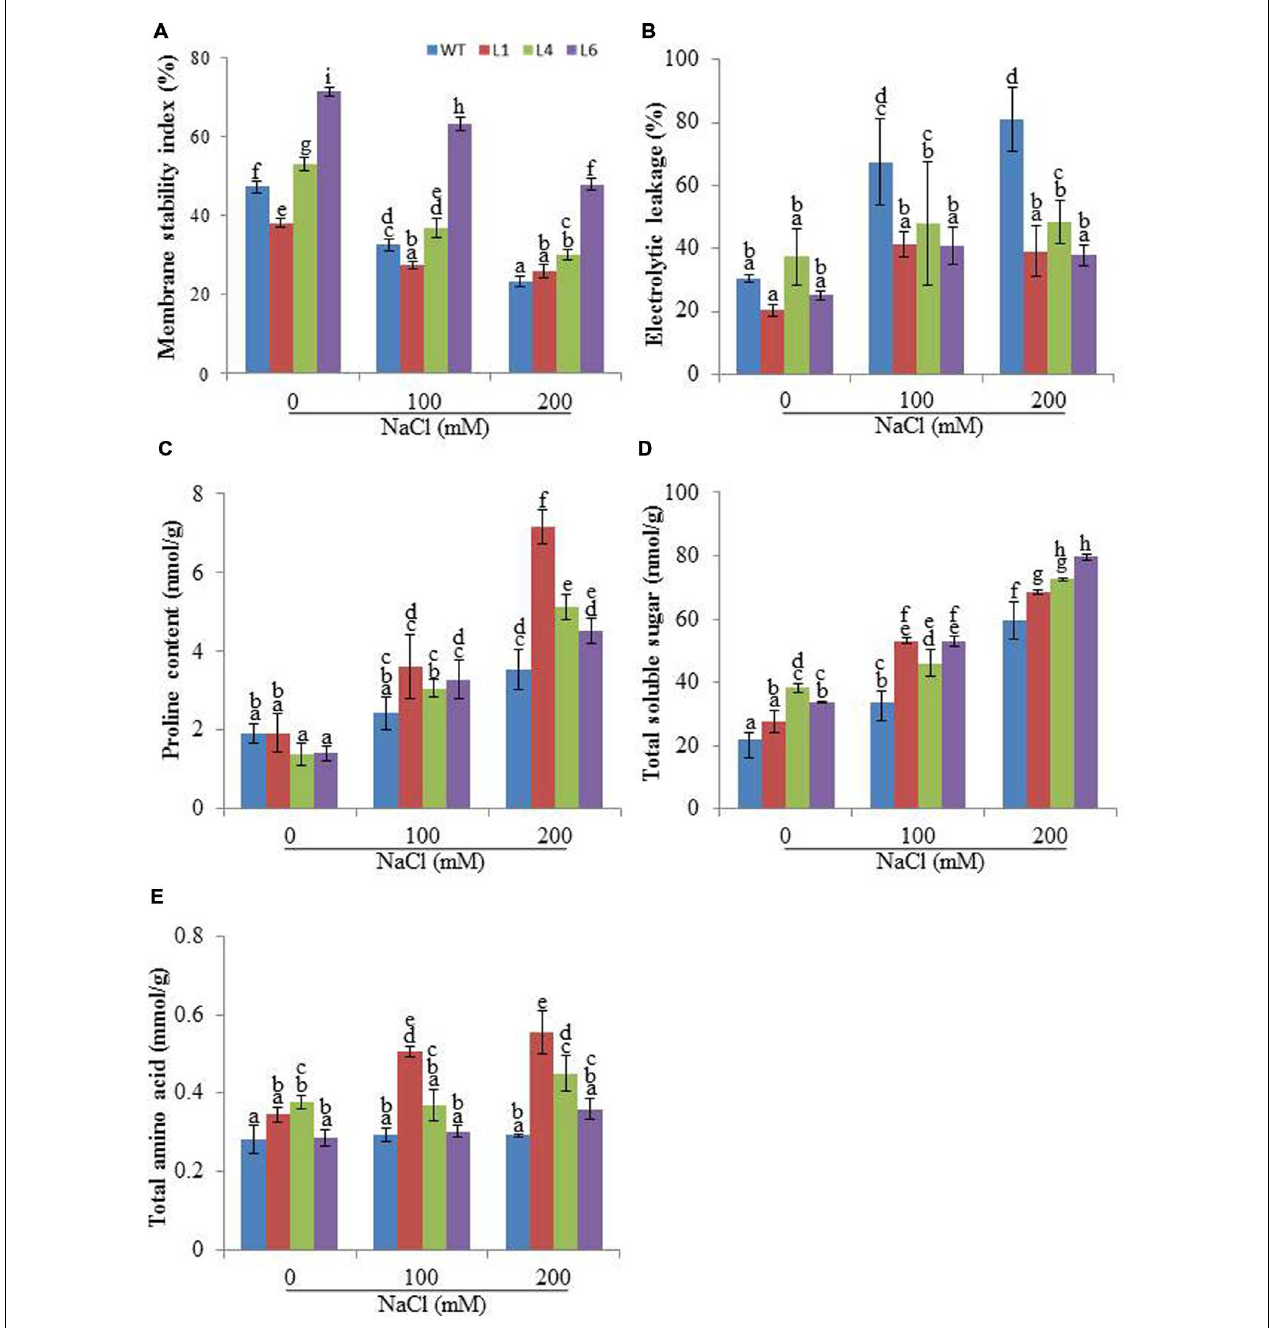
FIGURE 4 | Biochemical changes in WT and JcPR-10a transgenic plants grown in the presence of 0, 100, and 200 mM NaCl. (A) Membrane stability index (MSI), (B) Electrolyte leakage (EL), (C) Proline content, (D) Total soluble sugar (TSS) content, and (E) Total amino acids (TAAs) content. Values are represented as means ± SE ( n = 3) and marked with different alphabets to indicate significant difference at P ≤ 0.05 probability.